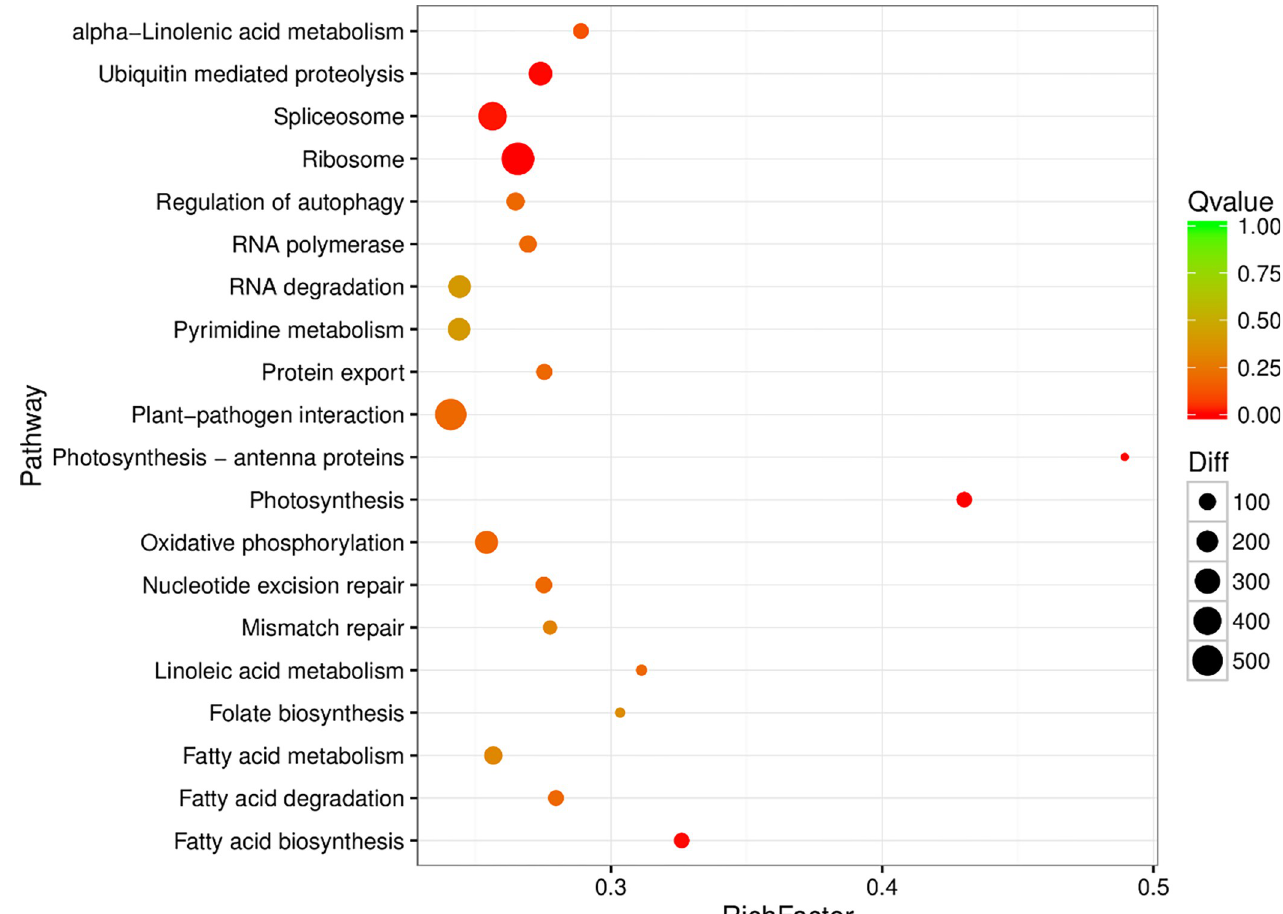
Fig 8. Pathway enrichment analysis of differentially expressed